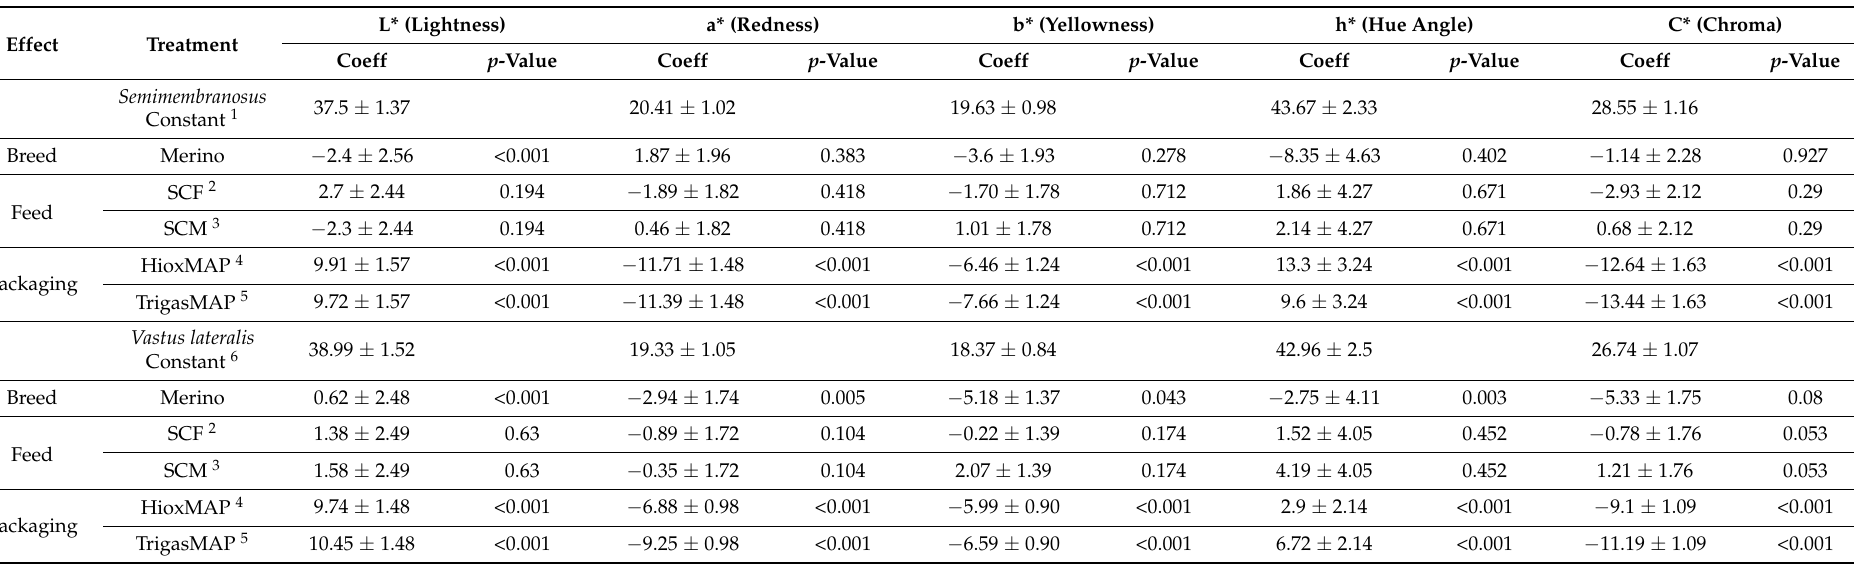
Table 1. Effect of breed, feed and packaging method on the CIELab colour parameters of sheep Semimembranosus and Vastus lateralis after 10-day retail